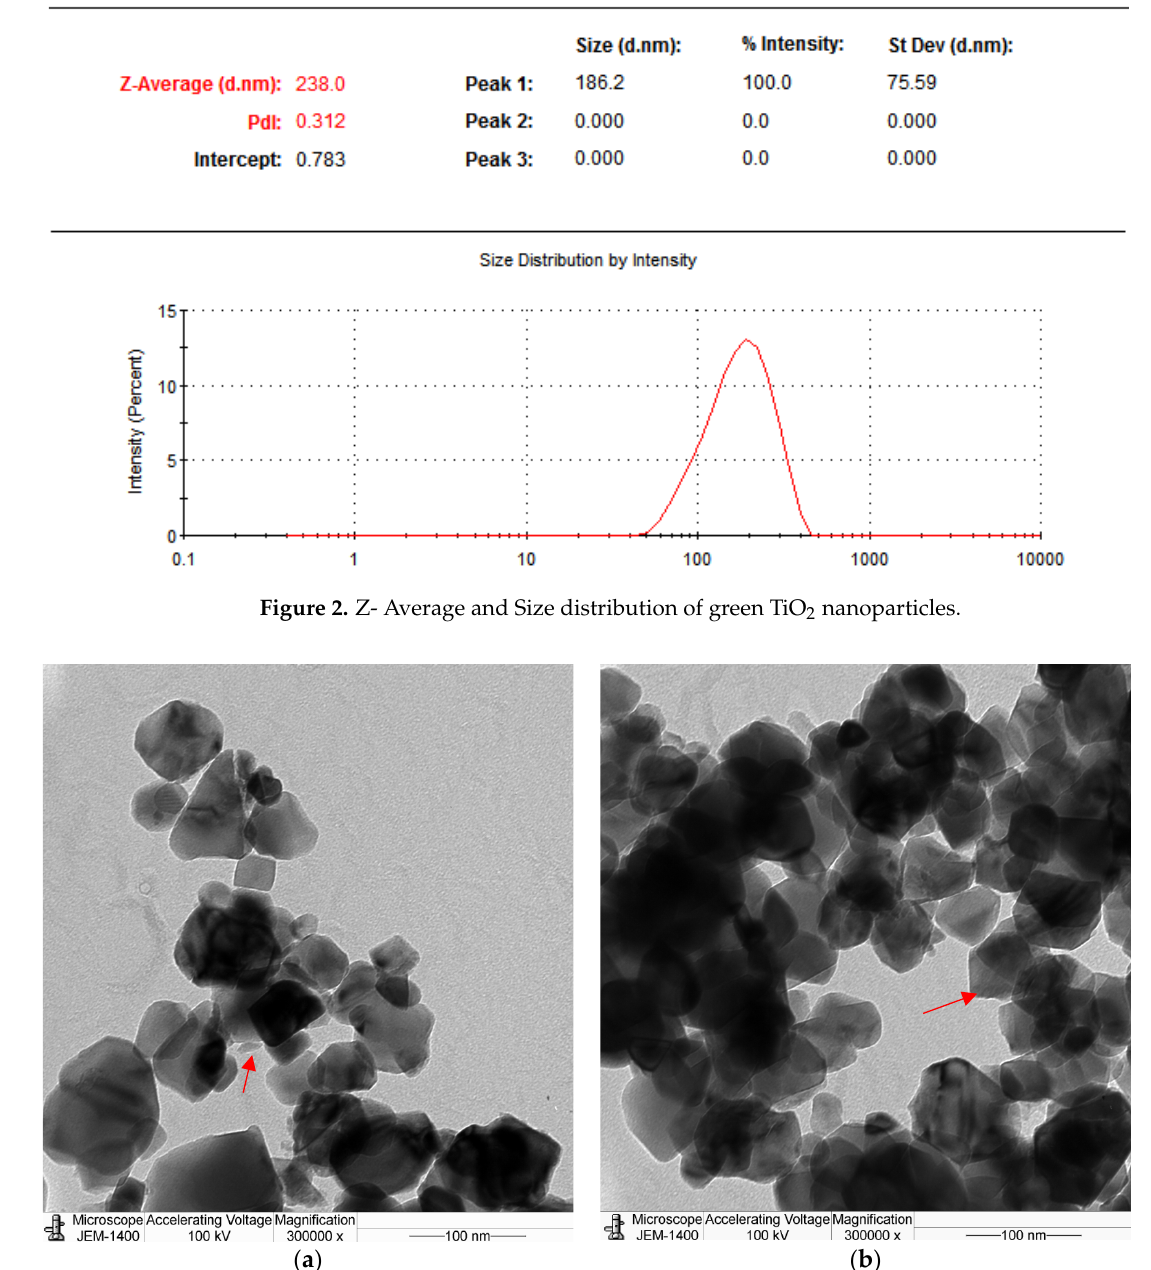
Figure 3. Transmission electron microscopy images of green TiO 2 nanoparticles. ( a ) irregular ( b ) hexagonal in shape.